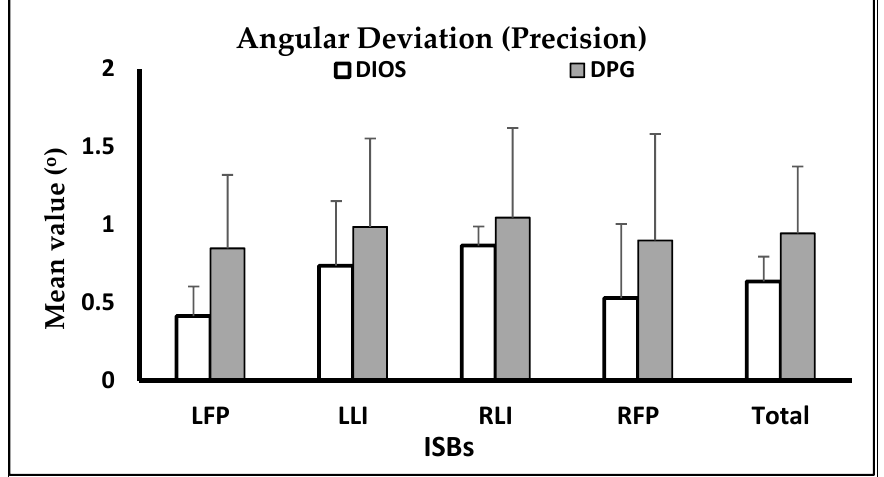
Figure 7. Mean values of angular deviations among impression techniques when evaluating precision. ISBs, intraoral scan-bodies; LFP, left first premolar; LLI, left lateral incisor; RLI, right lateral incisor; RFP, right first premolar; DIOS, digital intraoral scanning; DPG, digital photogrammetry.